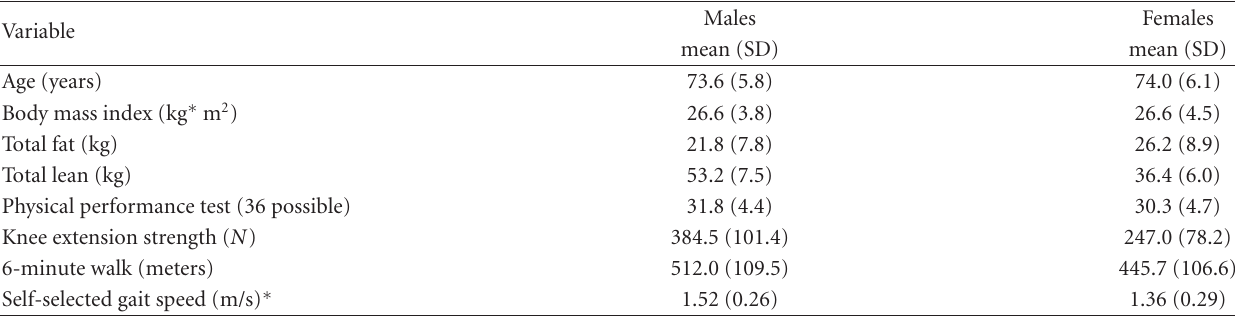
Table 1: Characteristics of the 202 participants (males n = 102, females n =